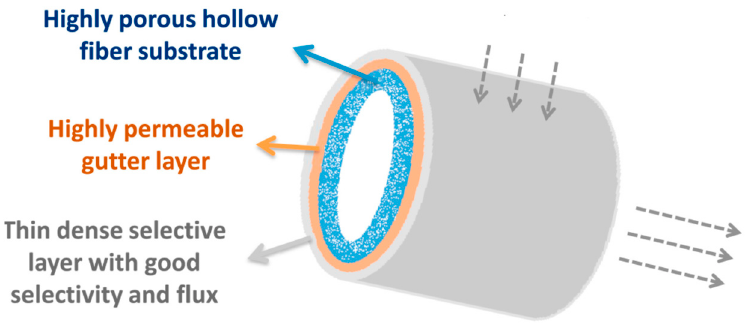
Figure 8. PEBAX thin selective layer [88]. Table 3. Summary of non-functionalized and amine-functionalized MOFs based hollow fiber mixed matrix membrane for CO 2 /CH 4 separation.